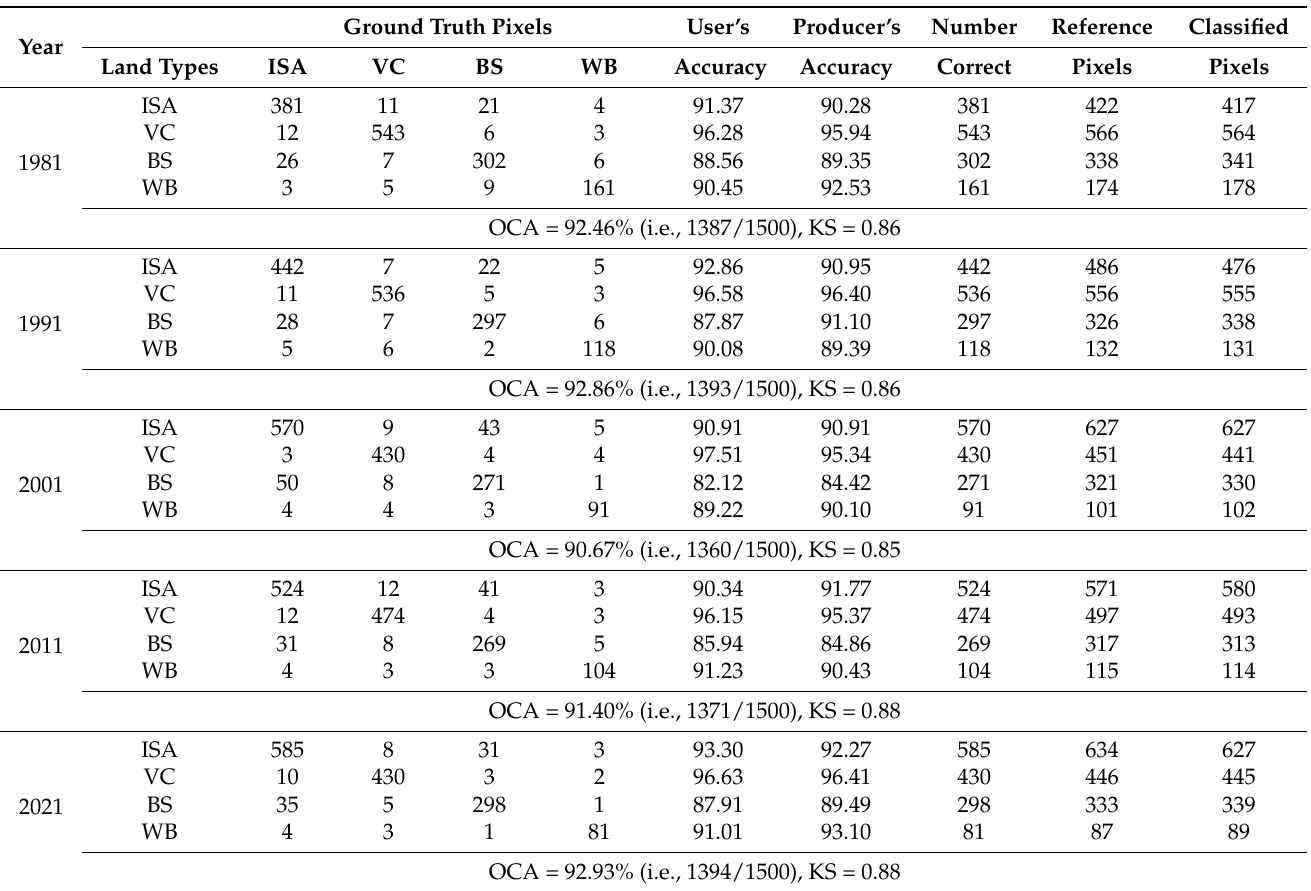
classification, with a 10% component interval from level 1 to level 10 (i.e., the component value from 0.01% to 100%), was applied to improve the accuracy evaluation. A combination of actual values and reference values was used to calculate the accuracy. Additionally, we obtained the fitting coefficient (R 2 ) and mean square error (RMSE) over 0.8965 and 12% in each studied year. Table 3. Accuracy evaluation matrix and indicators in years of 1981, 1991, 2001, 2011, and